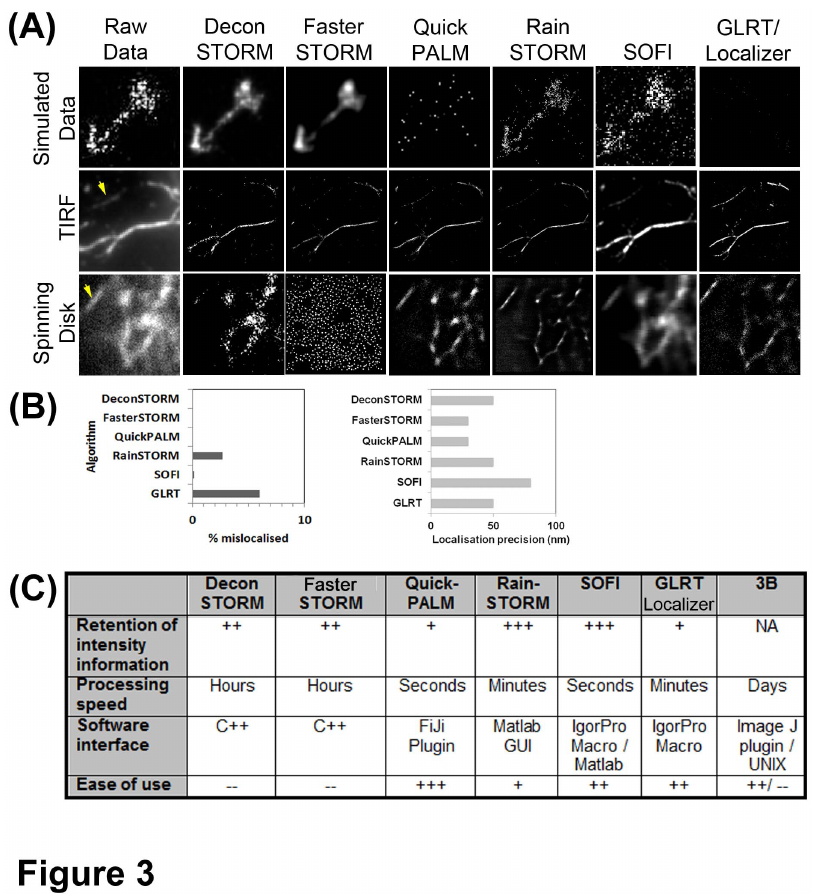
Figure 3. Comparative study of different stochastic super-resolution image processing algorithms. (A) Reconstructed super-resolution images from: a simulated dataset of 800 frames, a 64 6 64 pixel, 5000 frame dSTORM dataset of actin filaments labelled with AlexaFluor647 visualised by TIRF microscopy, a 90 6 90 pixel 5000 frame PALM dataset of Hela cells transfected with Eos-Actin. SR images were generated using DeconSTORM, FasterStorm, QuickPALM, RainSTORM, 3 rd order SOFI and GLRT implemented in the Localizer image analysis package respectively. An image of the raw, unreconstructed, data is shown for comparison. For TIRF and SD this is the average of 8 frames of data, for the simulated data a maximum intensity projection of the whole dataset is shown. (B) Graphs showing the percentage of mislocalized pixels in datasets reconstructed from a noisy background image. The noisy background image was generated by acquiring 5000 frames of images of a red fluorescent Perspex slide. Graph showing the predicted localization precision between all of the investigated algorithms. (C) Chart comparing retention of intensity information, processing speed, software interface and ease of use of the software of all the algorithms in the comparative study.